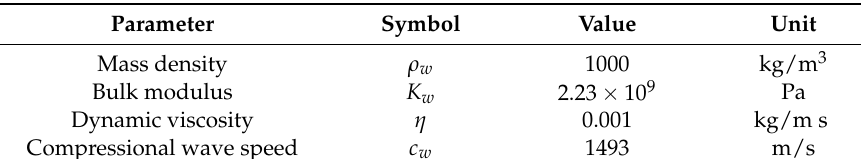
Table 2. Known parameters for water.